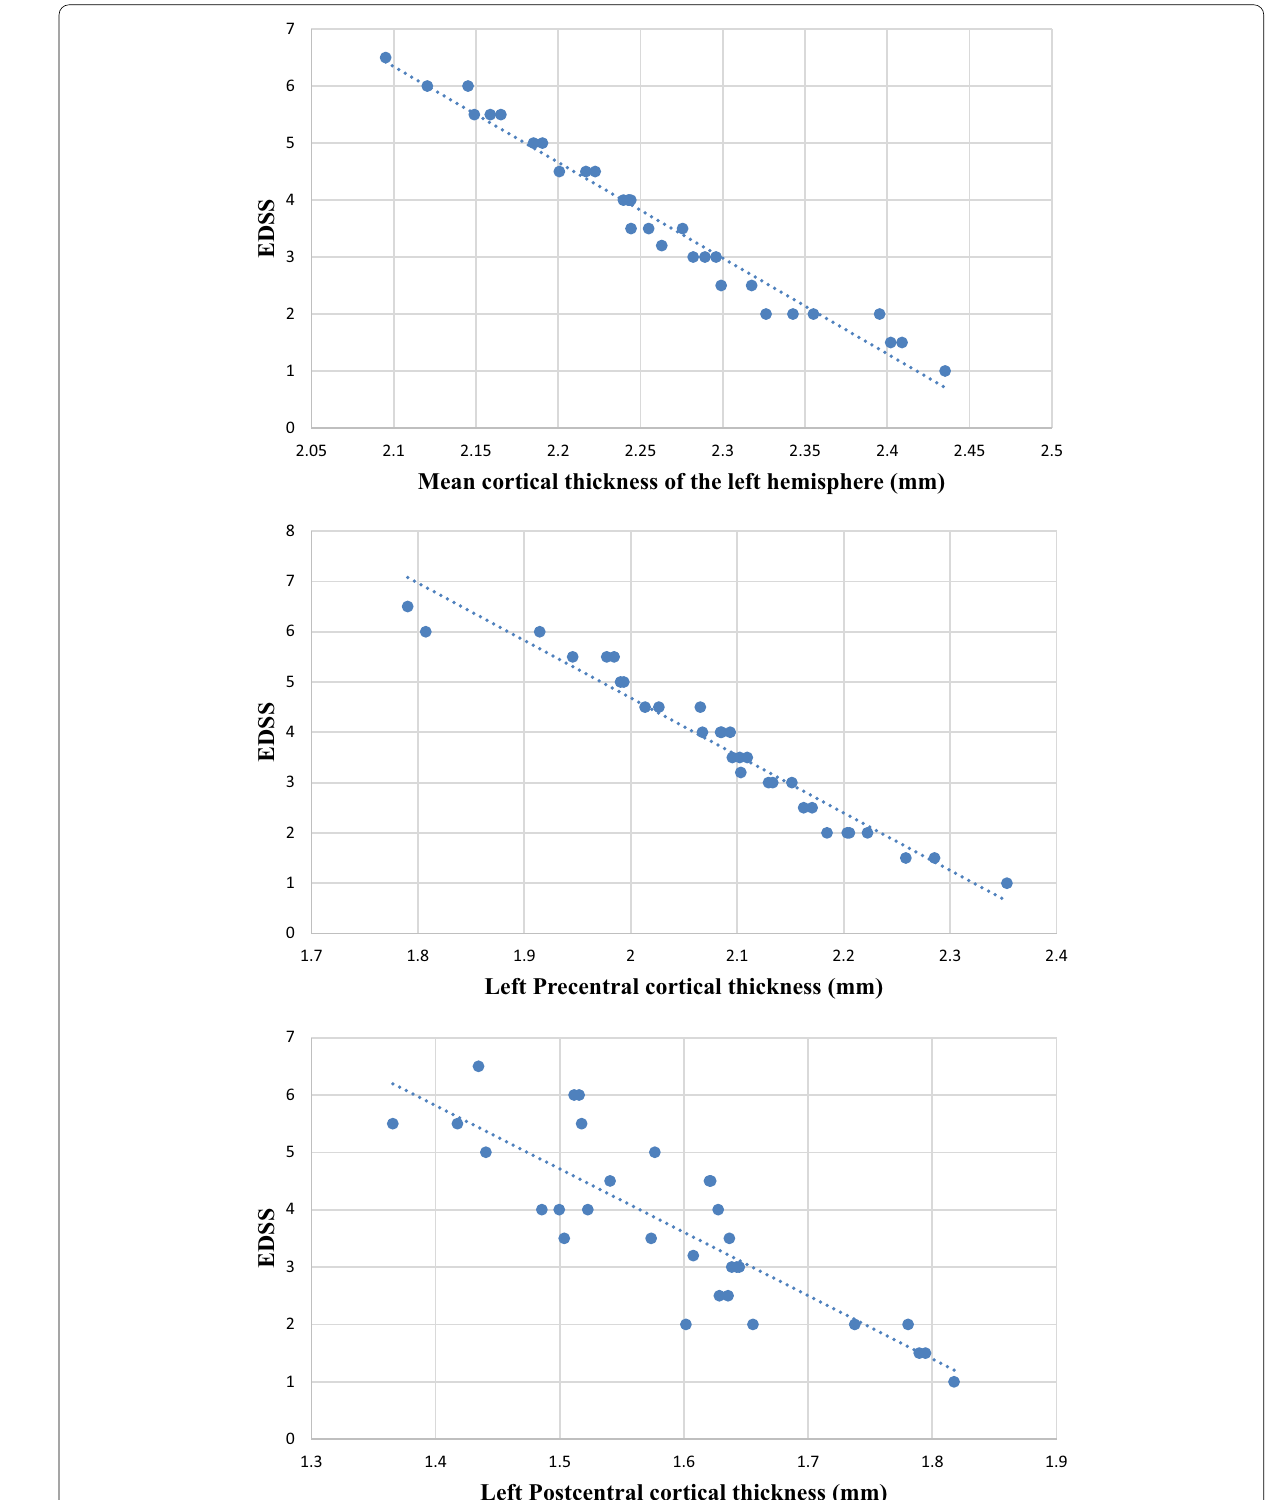
Fig. 5 Correlation between the mean cortical thickness of the left hemisphere, the left precentral, postcentral, paracentral, posterior cingulate cortical thickness and EDSS